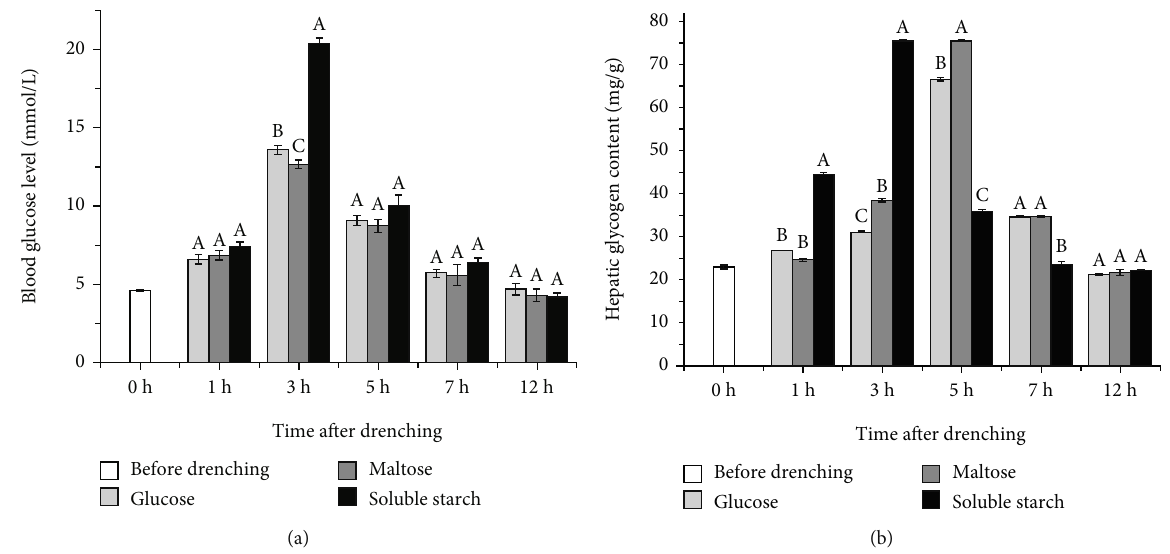
Figure 3: The e ff ects of oral administration with di ff erent carbohydrates on (a) blood glucose and (b) hepatic glycogen level of S. denticulatus . At the same time, di ff erent uppercase letters indicate the values with signi fi cant di ff erences ( P < 0 : 05